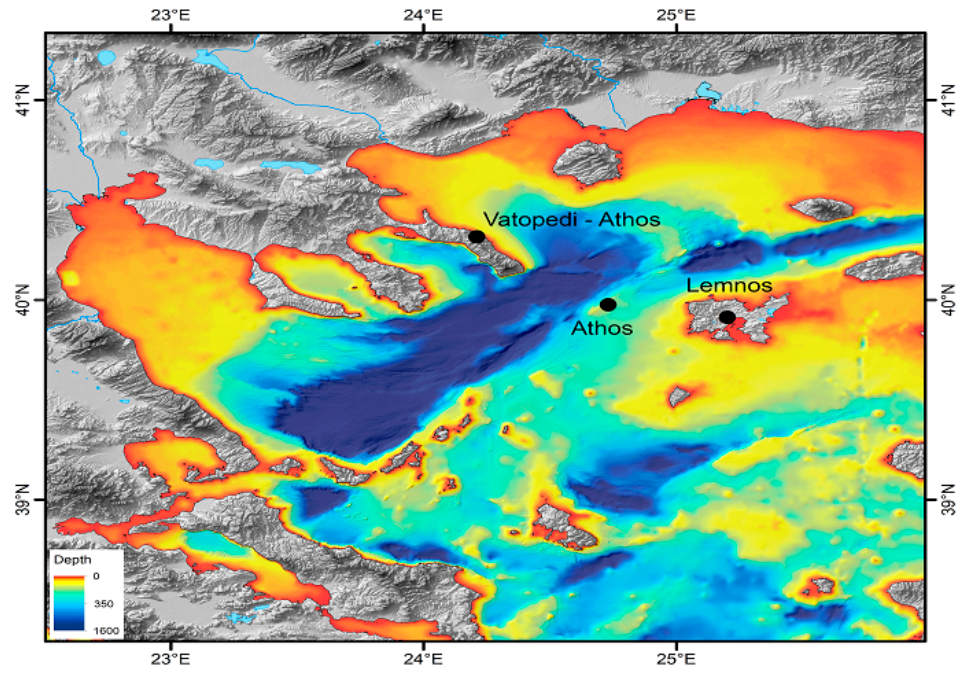
Figure 1. The area of study.